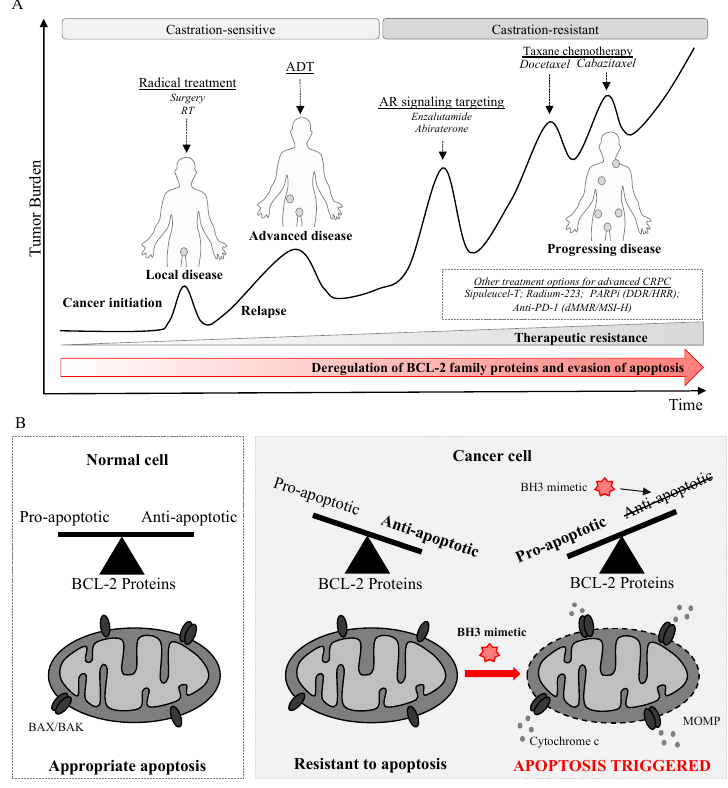
Figure 2. Evasion of apoptosis drives tumorigenesis, progression and therapeutic resistance in prostate cancer providing rationale for targeting anti-apoptotic BCL-2 proteins with BH3 mimetics. ( A ). An example of prostate cancer progression and treatment. Three-quarters of men are diagnosed with localized disease and can be treated with curative intent (prostatectomy or radiotherapy). and relapse occurs in 20 to 50% after radical treatment for early-stage disease. Most advanced prostate cancers respond to androgen deprivation therapy (ADT) but they inevitably progress from castration-sensitive to castration-resistant prostate cancer (CRPC). Approved therapies for advanced CRPC include androgen receptor (AR) signaling targeting, taxane-based chemotherapy and radium- 223 but primary and acquired resistance is common. Tumors with aberrations in homologous ribose) polymerase (PARP) inhibitors and anti-PD-1 therapy can be used for defective mismatch repair (dMMR) or microsatellite instability-high (MSI-H) disease. Treatment sequence can vary considerably